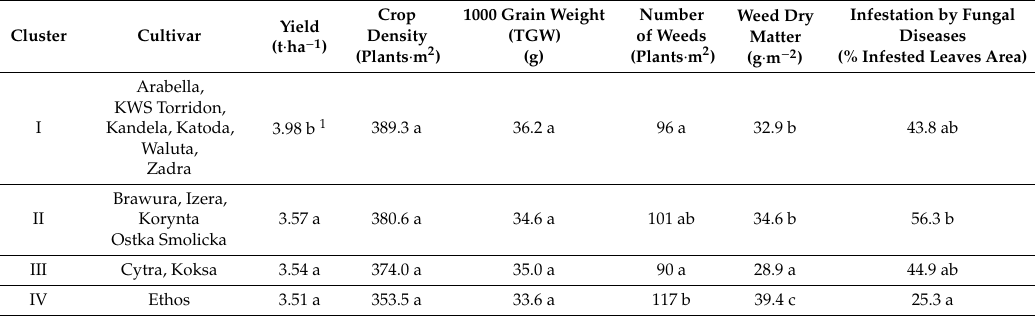
Figure 1. Ordination diagram of agronomic traits and spring wheat varieties in relation to first and second axis of PCA. Table 6. Value of agricultural traits of spring wheat varieties ( n =